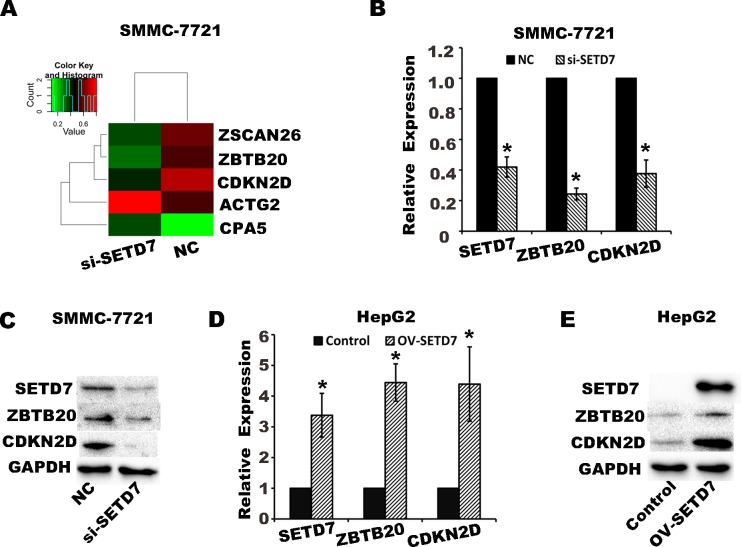
SETD7 regulates the expression of ZBTB20 and CDKN2D.(A) Differential gene expression profile was explored and analyzed after SETD7 knockdown in SMMC-7721, as shown in Heatmap (q-value<0.05). (B, C) qRT-PCR and western blot analysis indicate that after SETD7 knockdown in SMMC-7721, the expression levels of ZBTB20 and CDKN2D were significantly downregulated. *P< 0.05 by Student’s t-test. (D, E) qRT-PCR and western blot analysis indicated the ZBTB20 and CDKN2D were significantly upregulated in SETD7 overexpression in HepG2 cells. *P< 0.05 by Student’s t-test.